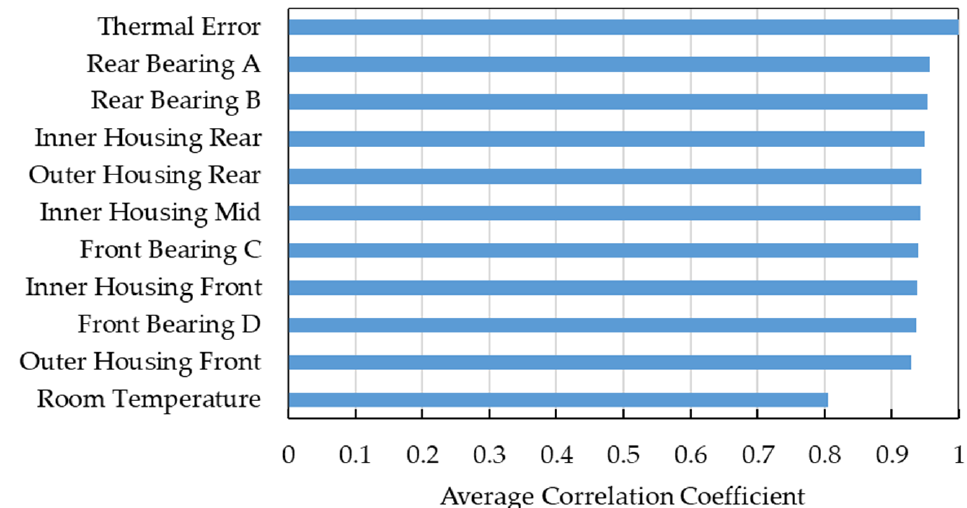
Figure 10. The external validation of the thermal error model trained by random forests under the rotational speed of ( a ) 5000 rpm; ( b ) 6000 rpm; ( c ) 7000 rpm; ( d ) 8000 rpm; ( e ) variable speed.